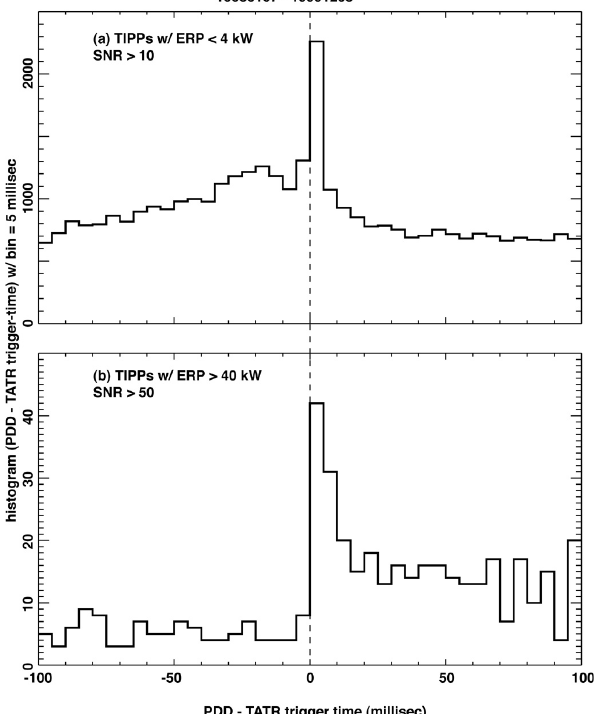
Fig. 9. Histograms of PDD–TATR trigger-time differences, for autonomously triggered TATR and autonomously triggered PDD. (a) Weak TIPPs. (b) Strong TIPPs.